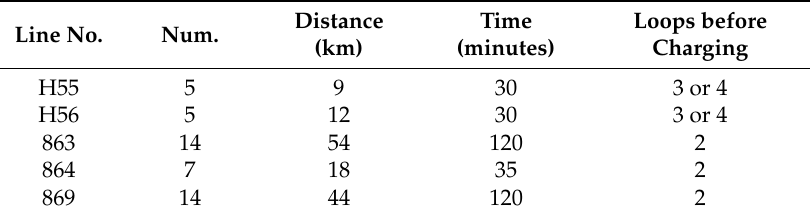
Table 2. The operation details for each line.